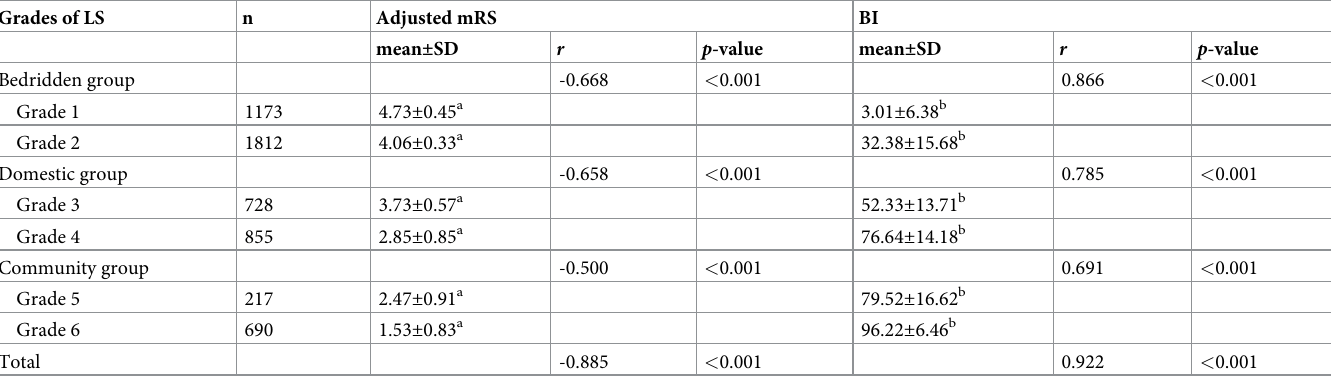
Table 3. The correlations among LS with adjusted mRS and